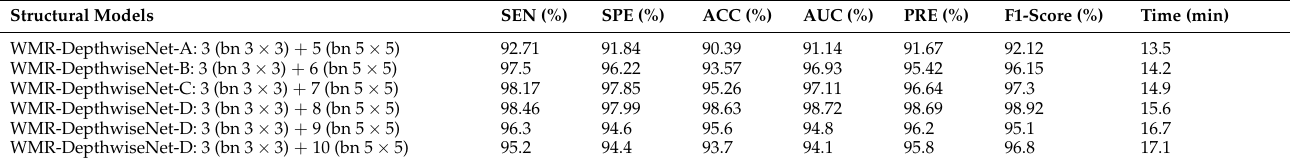
Table 4. Performance evaluation of the structural configuration of our proposed model with different depthwise bottleneck modules for CXR dataset. bn represents the bottleneck module.